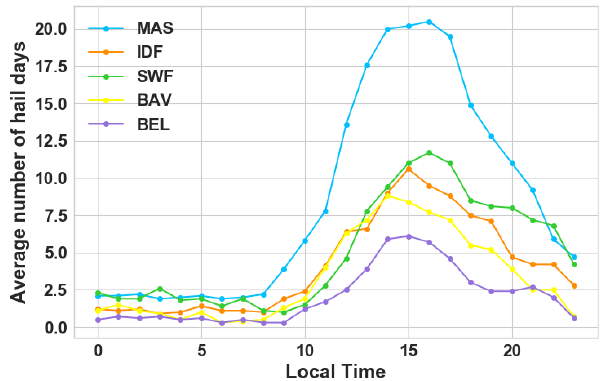
Figure 7. Time-series of the mean number of radar-derived hail days for consecutive 10d periods for the subdomains BEL, IDF, BAV, MAS and SWF shown in Fig. 3.